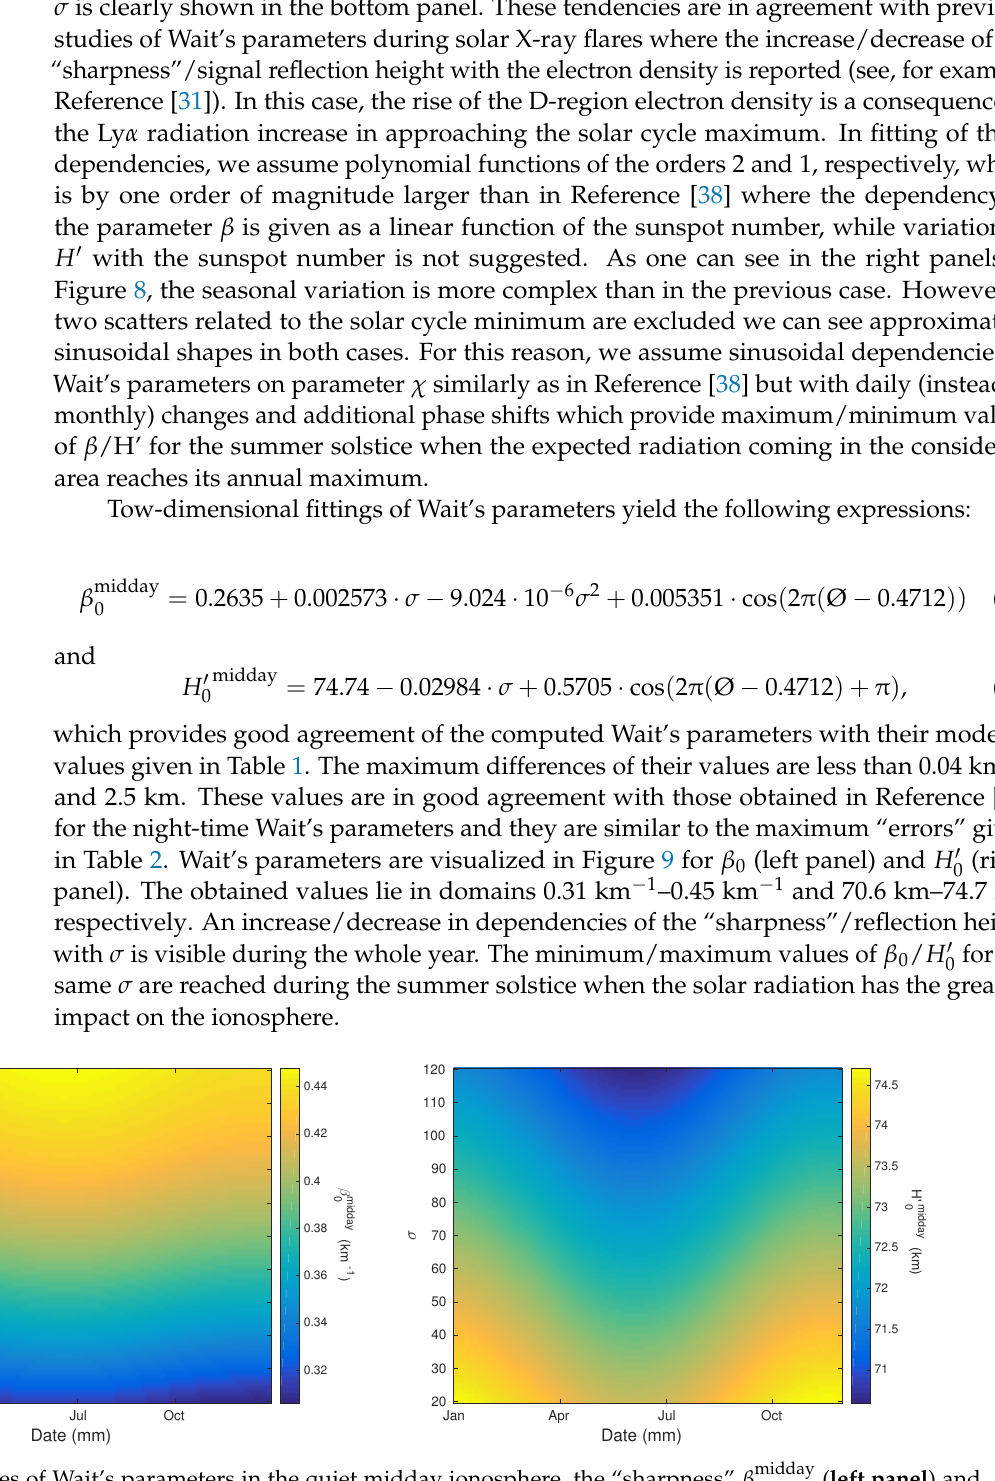
( left panel ) and 0